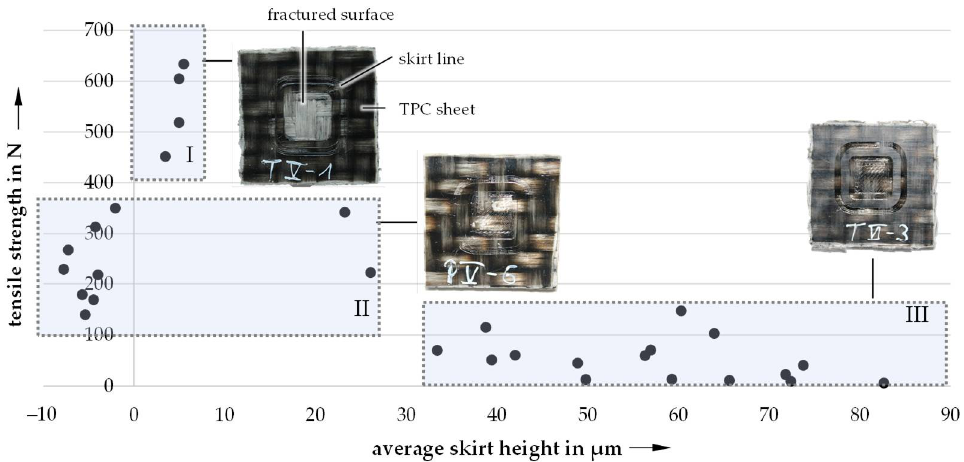
Figure 5. Influence of the FLM nozzle distance on the bonding strength by means of averaged skirt heights.